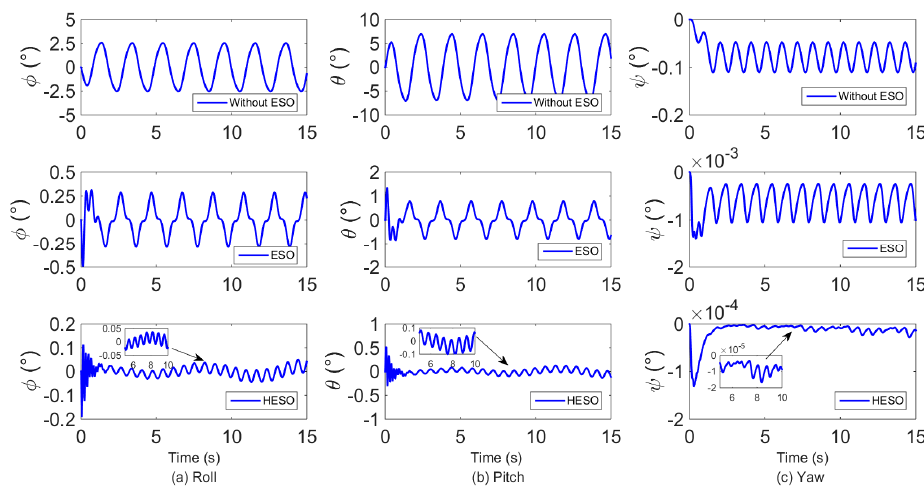
Figure 3. Simulation curves of the attitude angle in attitude stabilization: ( a ) roll channel; ( b ) pitch channel; ( c ) yaw channel. Electronics 2018 , 7 , x FOR PEER REVIEW